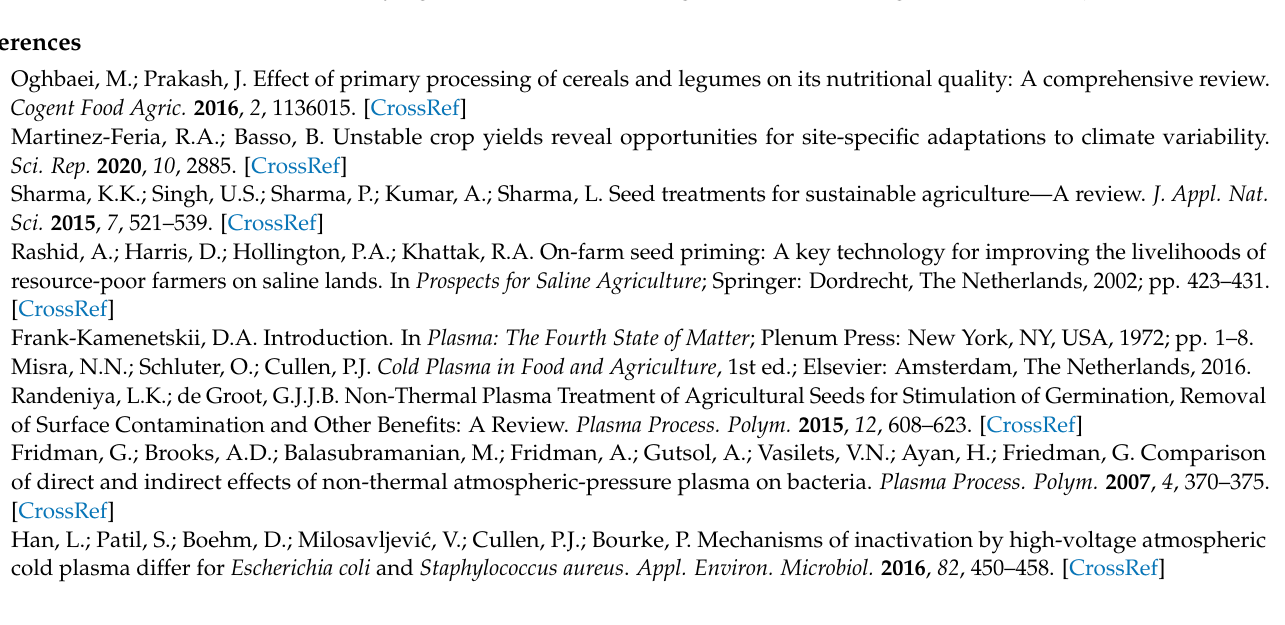
Figure A2. The average length of the longest root per plant ( a ), total sum of root length per plant ( b ), the average shoot length per plant ( c ), and the average fresh weight of the shoot ( d ). Seeds were treated in the glow plasma regime for 30 (G30) or 90 s (G90), and in the afterglow regime for 30 (AG30) or 90 s (AG90). Displayed values are the mean ± SE of three replications. Letter a indicate statistically significant differences among treatments according to Duncan’s test ( p < 0.05).